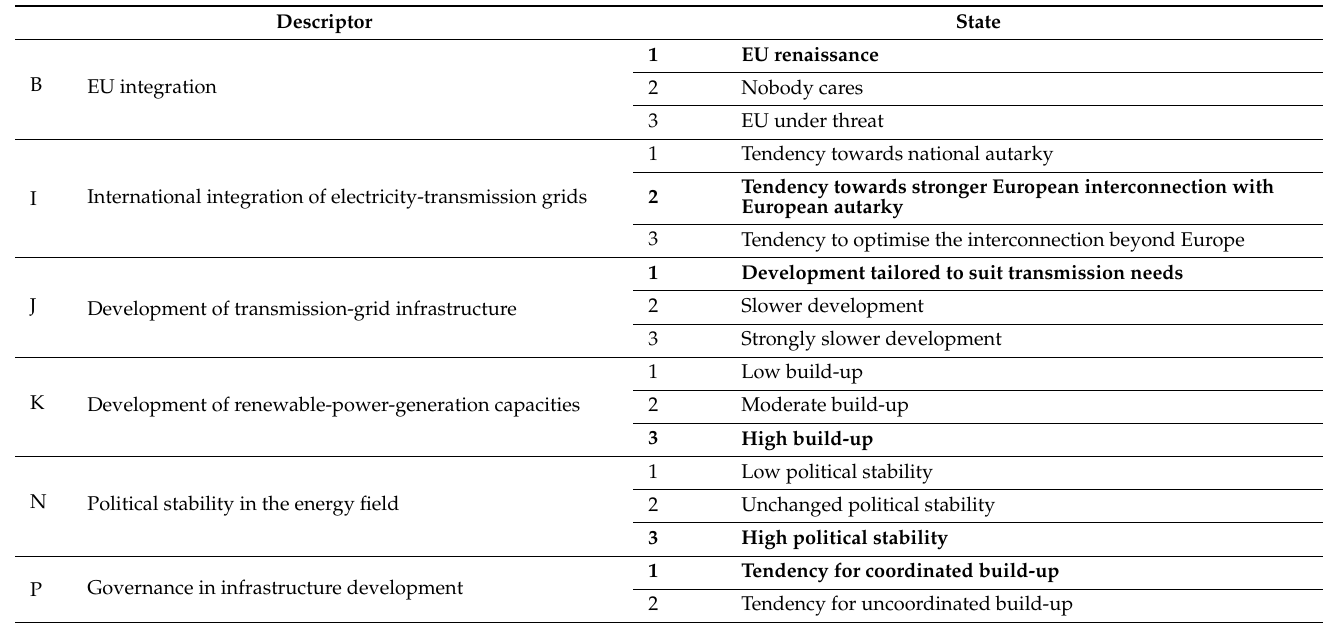
Table 3. Descriptors of cluster “EU achievements regarding energy supply”, and corresponding states that define the base scenario highlighted in